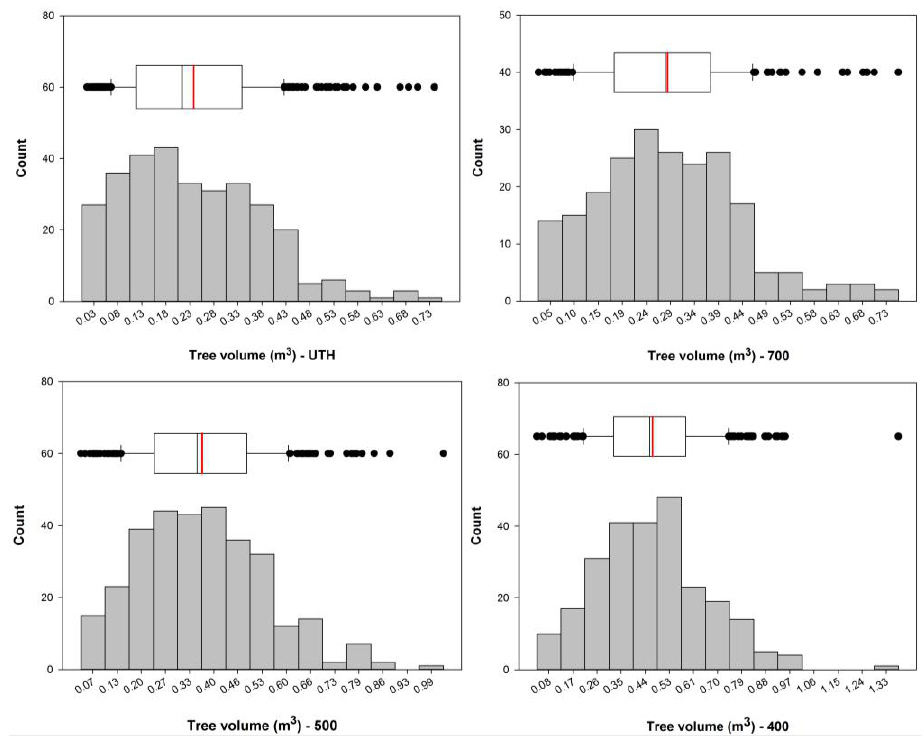
Figure 1. Combined histogram/box-plot charts for variate “Tree volume” by stocking treatment. The vertical red line in the box plot corresponds to the mean value.